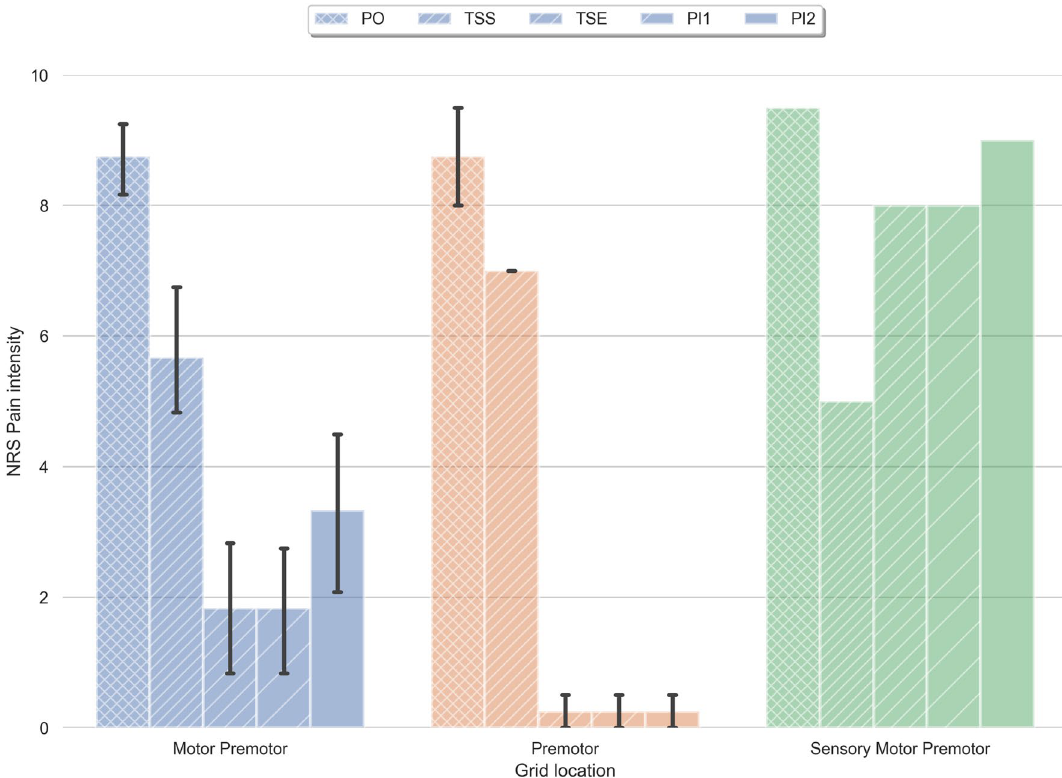
Figure 4. Comparison of ESCC effects in three groups based on electrodes location. Blue—electrodes implanted over motor and premotor cortex (n = 6); Brown—electrodes implanted over premotor and prefrontal cortex (n = 2); Green—electrodes implanted over sensory, motor, and premotor cortex (n = 1). PO—preoperative pain level (NRS); TSS (trial stimulation start)—pain level when trial stimulation was started; TSE (trial stimulation end)—pain level by the end of trial stimulation; PI1 (post-implantation 1)—permanent grid post-implantation pain level within 2 weeks; PI2 (post-implantation 2)—permanent grid post-implantation pain level that had been achieved after adjustment of stimulation settings within 6–12 months of observation. Means ± standard deviation of the mean.